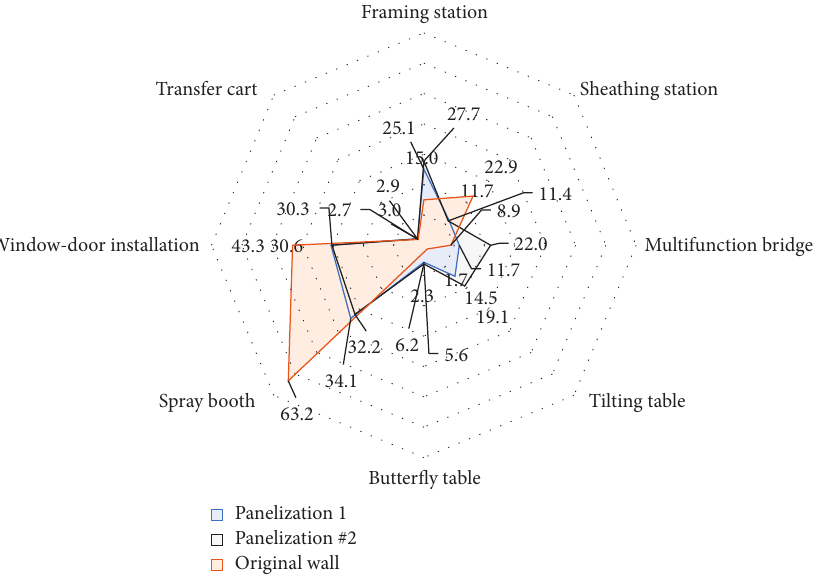
Figure 10: Total duration for each workstation, cycle time +waiting